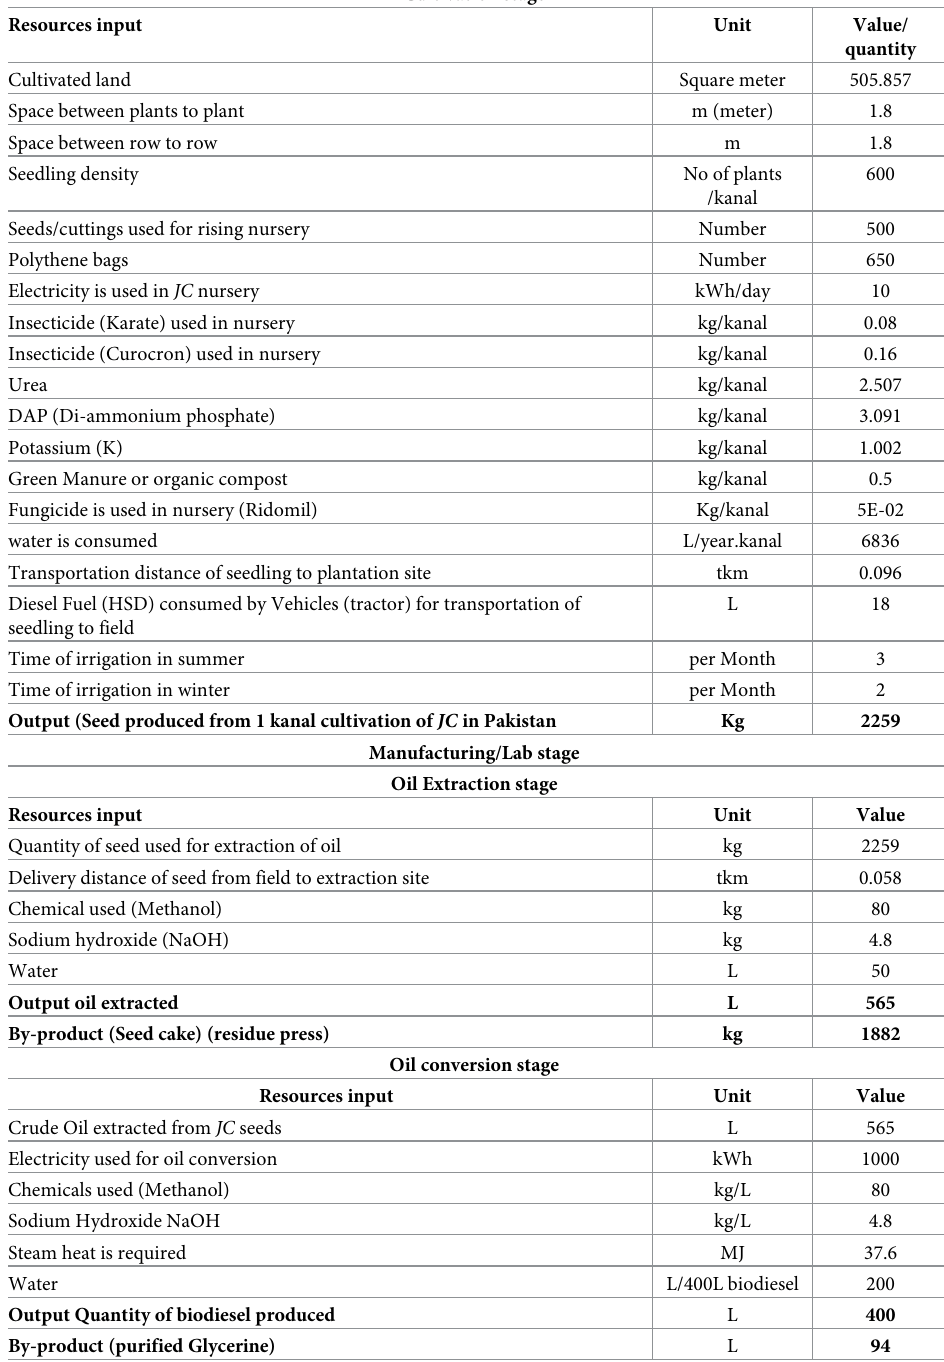
Table 1. Life cycle inventory of inputs/outputs to produce 400L biodiesel from JC seeds oil in